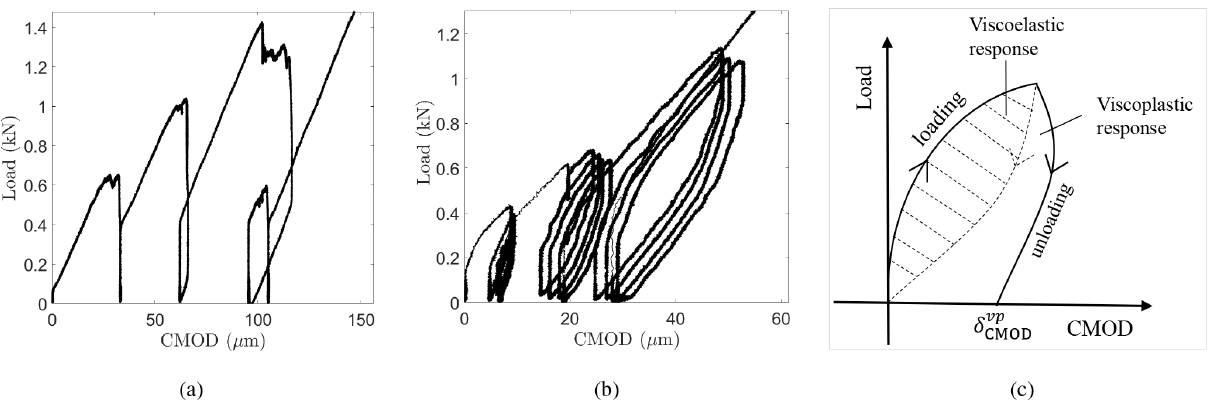
Figure 6. Load versus CMOD over the (a) creep-recovery cycles for RP15 and the (b) cyclic-recovery sequences for RP17. (c) Schematic illustration of the hysteresis load-displacement diagram. The whole of the hysteresis loop area is the energy loss per cycle. The dashed area is the part of that total that is due to the viscoelastic mechanism and the rest is due to viscous processes.